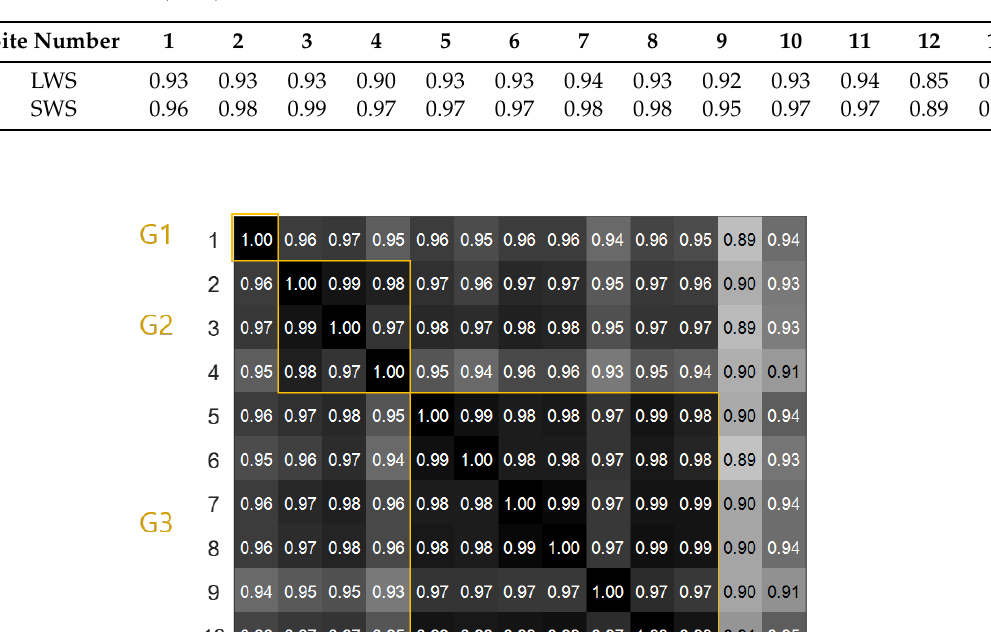
Table 2. Cross-correlation of the PV power output between the local weather station (LWS) and the site weather station (SWS).